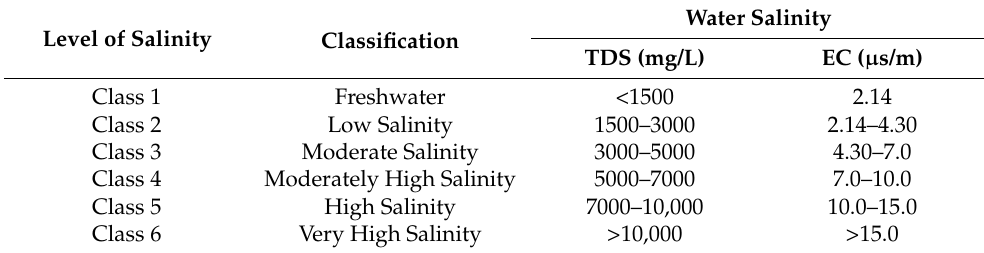
Table 1. Classification of groundwater salinity (adopted from